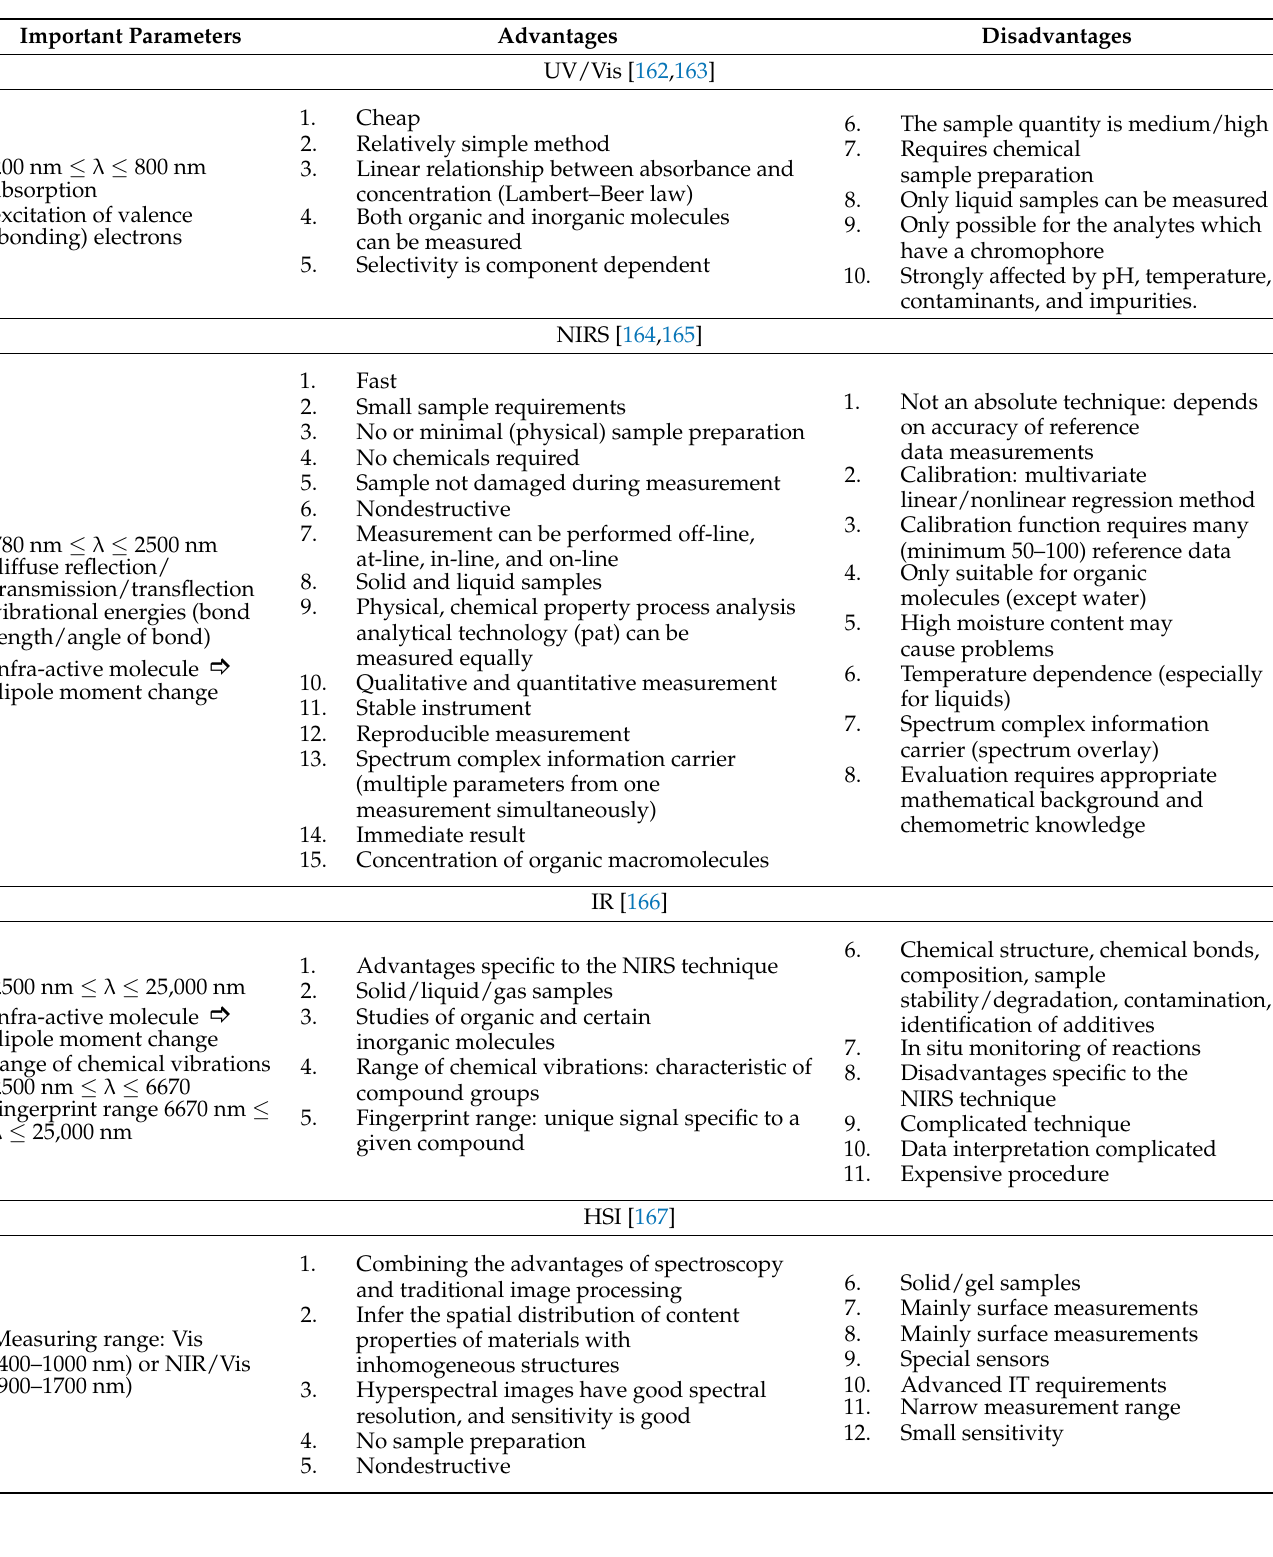
Table 2. Advantages and disadvantages of different molecular spectroscopy methods.